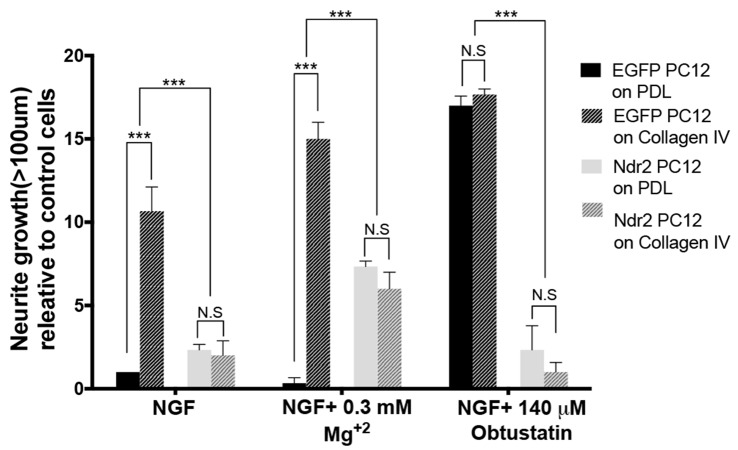
Lack of α1β1 integrin activation to stimulate outgrowth in Ndr2 overexpressing cells. Without additional integrin stimulation, control cells but not Ndr2 PC12 cells show an enhanced growth on collagen IV compared to PDL. Unspecific enhancement of integrin adhesion by 0.3 mM Mg2+ somewhat increases the neurite growth of Ndr2 PC12 cells on both PDL and Collagen IV, however, without reaching the high levels seen on collagen IV with control cells. The synthetic KTS ligand obtustatin induces growth in control cells on PDL to the same high level as on collagen IV. However, it does not stimulate growth of Ndr2 PC12 cells on either substrate. In summary, α1β1 stimulation by collagen IV substrate or a soluble KTS ligand stimulates neurite growth only in control cells, but not in Ndr2 PC12 (two-way ANOVA genotype × treatment interaction: F(6,24)= 41.05 p < 0.001). Values are mean + SEM; N = 3; ***p < 0.001; N.S p > 0.05.